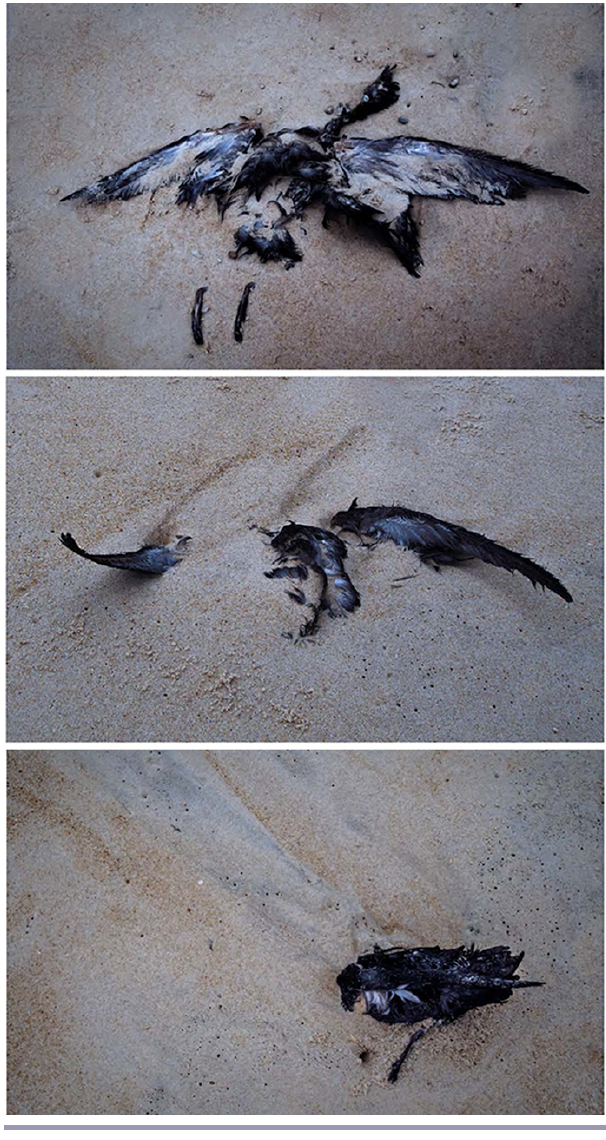
Fig. 2 . Shearwater burial triptych, Southeast Queensland,